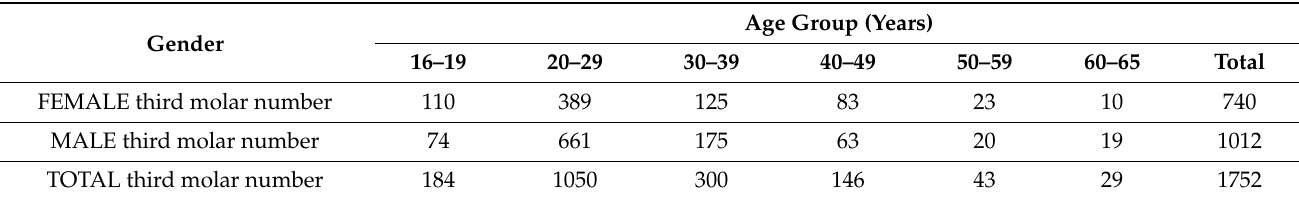
Table 2. Age and gender distribution of patients with third molar numbers.